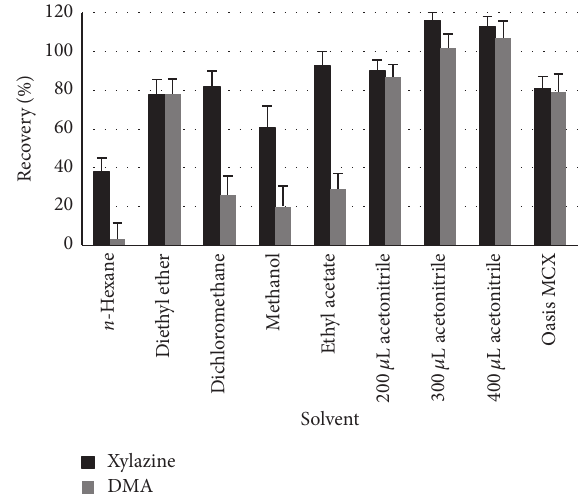
Figure 2: Effect of different SPE cartridges on the recoveries of xylazine and